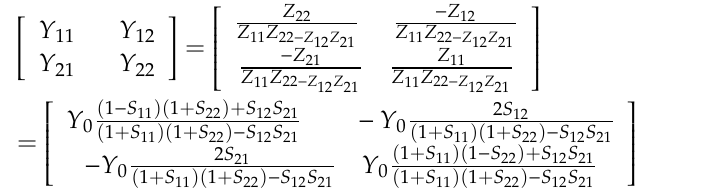
Figure 3. Photos of the sensor: ( a ) before and ( b ) after the gas sensing layer deposition.